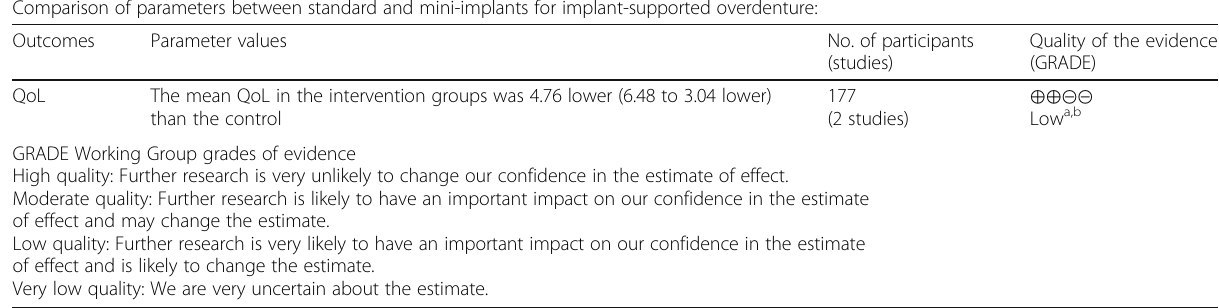
Table 2 Grading the strength of evidence Comparison of parameters between standard and mini-implants for implant-supported overdenture: Outcomes